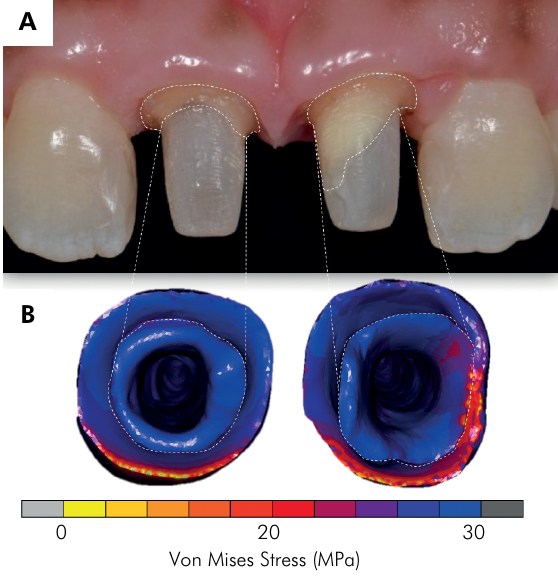
Figure 5. A. Central incisors with height and shape of ferrule presence; B. The stress distribution at the intracanal surface of the root dentin, showing that higher stress is found on area with shorter ferrule.